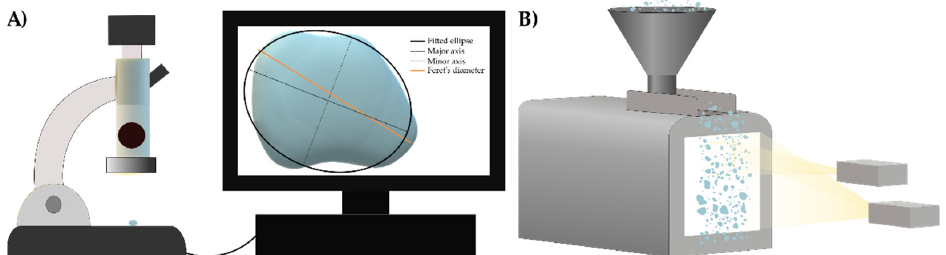
Figure 7. Schematic illustration of image acquisition methods (( A ): static; ( B ): dynamic image anal- ysis).